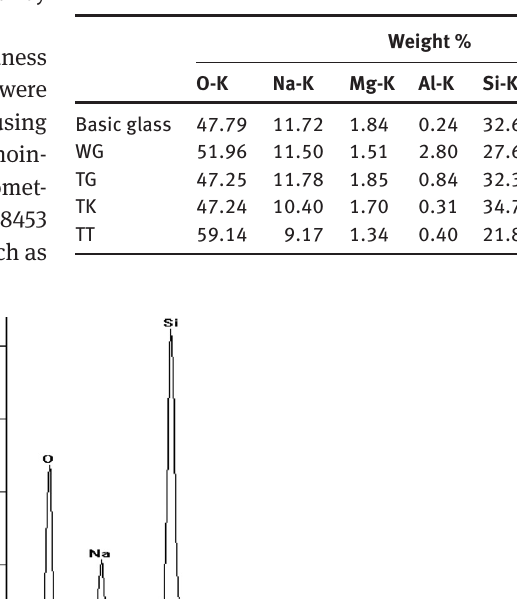
Table 1: The results of chemical composition analysis (SEM-EDS)